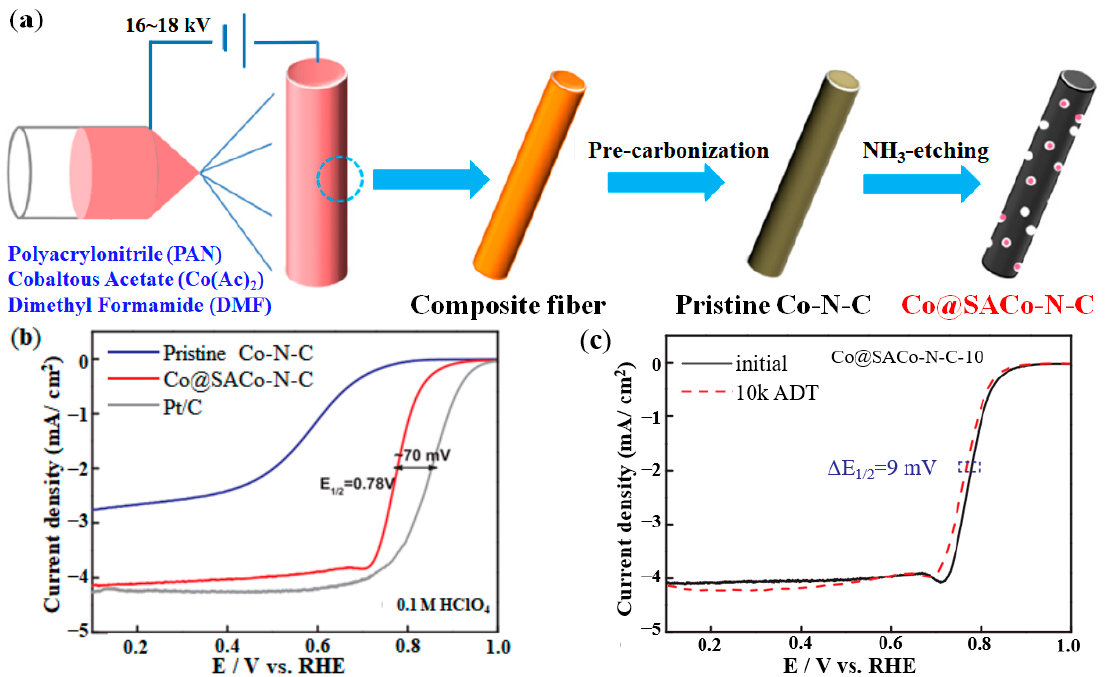
Figure 6. Synthesis method and performance of Co@SACo-N-C catalyst: ( a ) Synthesis diagram; ( b ) ORR activity; ( c ) ORR durability. Adapted with permission from Ref. [89]. Copyright 2018 Elsevier.